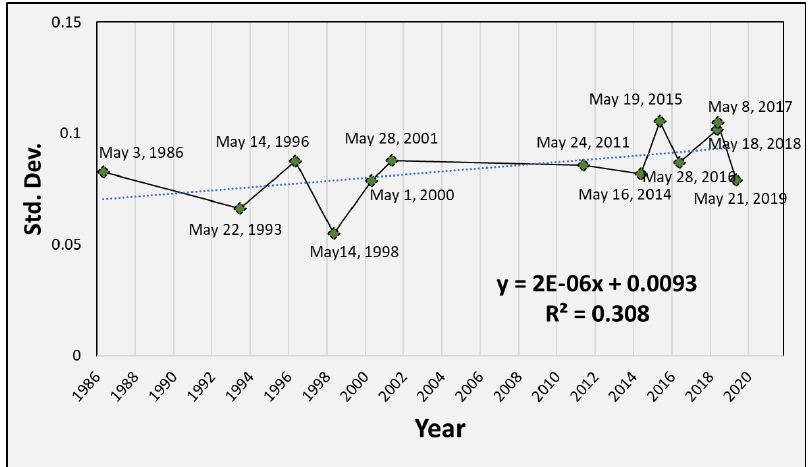
Figure 6. Yearly standard deviation from the 80 UGSs.